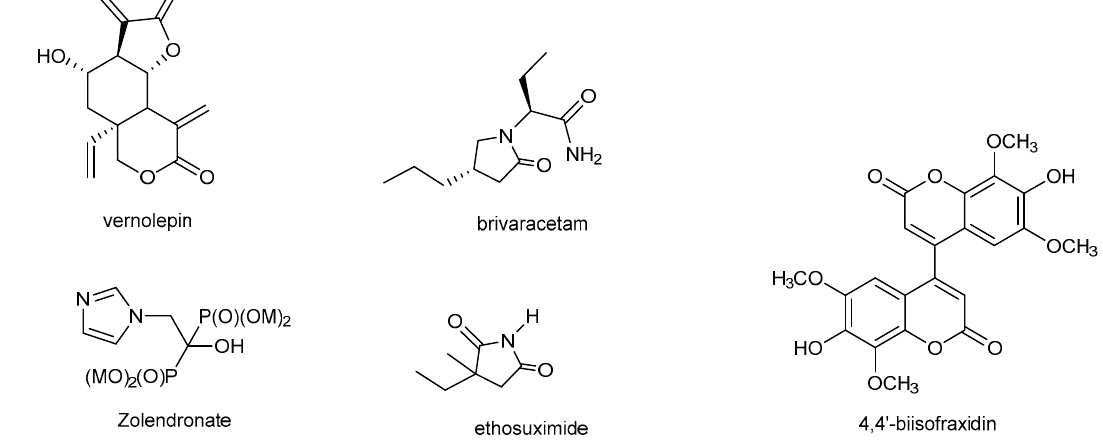
Figure 2. Biologically active compounds and drugs.